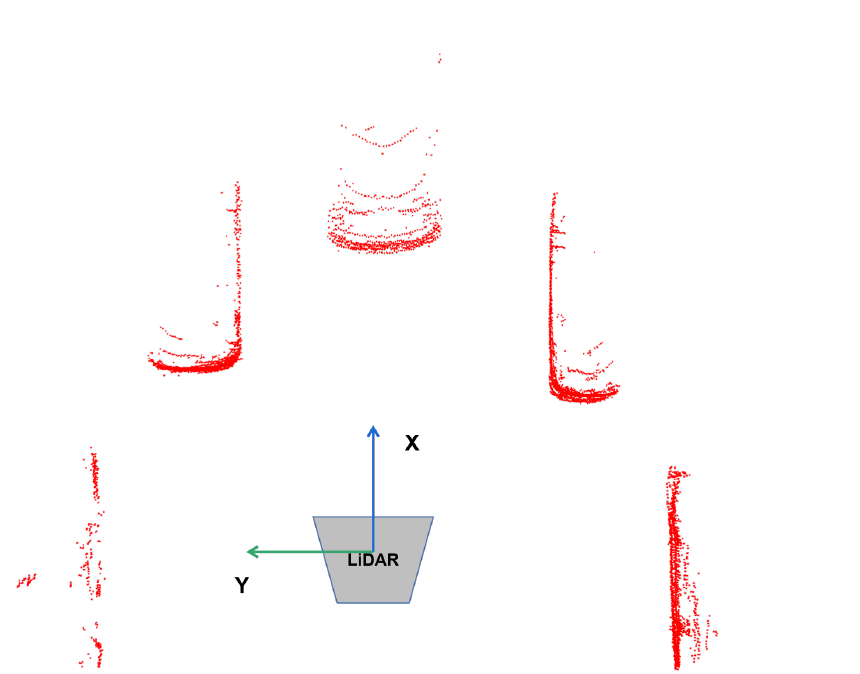
Figure 2. Point cloud distribution with the same orientation angle. In different locations, the distribu- tion of point cloud is completely different.